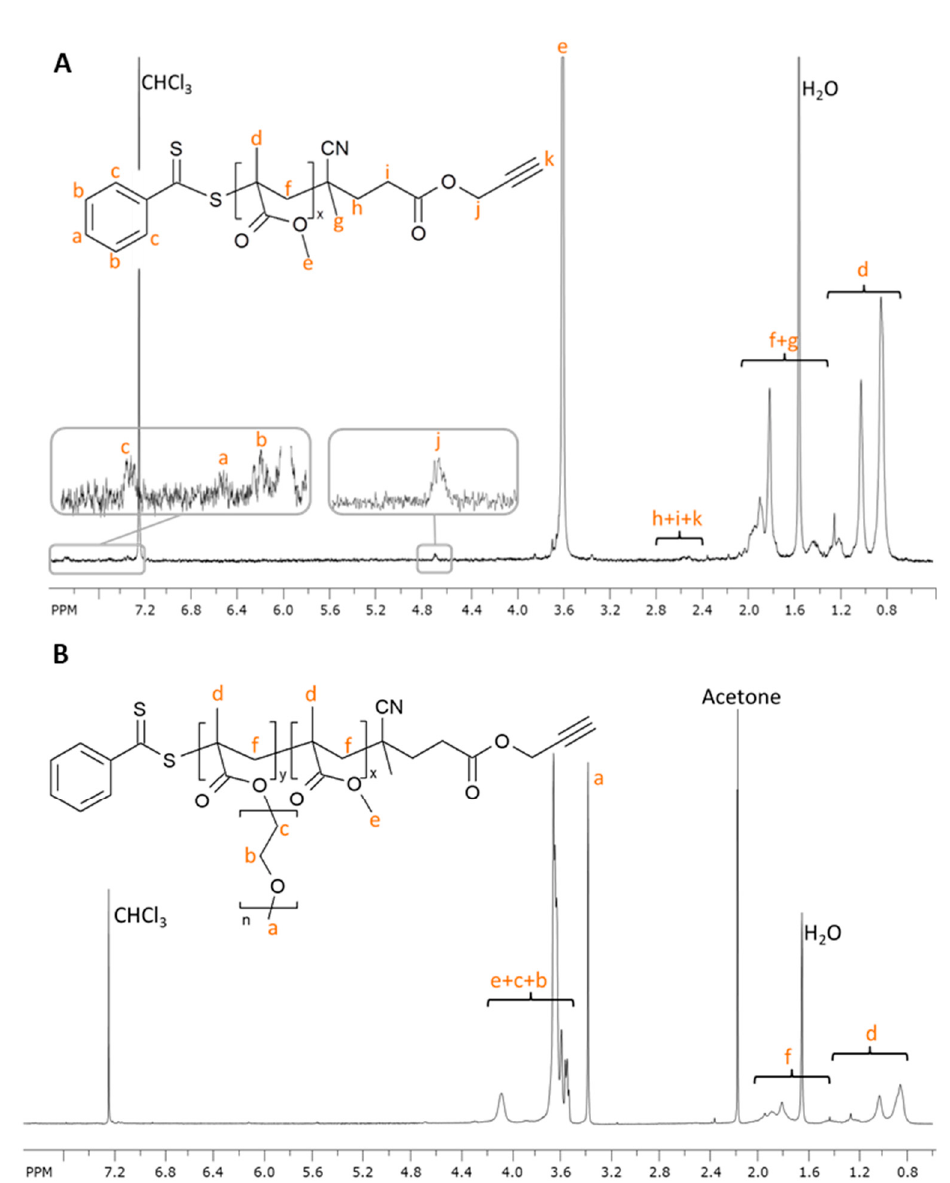
Figure 2. 1 H-NMR spectra in CDCl 3 of ( A ) PMMA-Alk and ( B ) POEGMA- b -PMMA-Alk block copolymer.